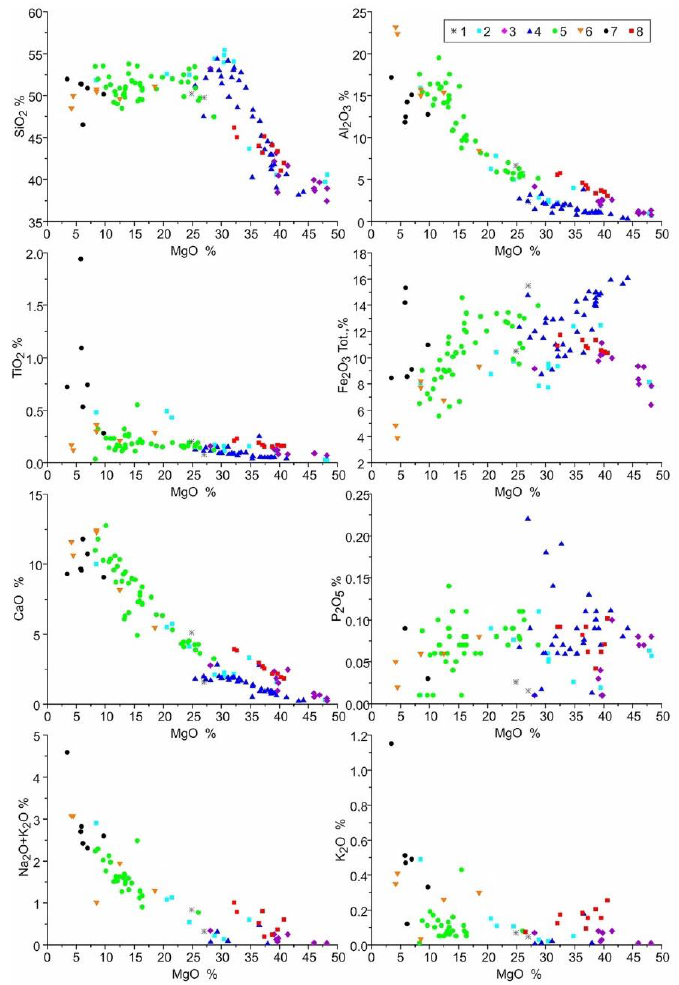
Figure 7. Petrochemical diagrams of MgO oxides in rocks of the Monchepluton and intrusive body (M-1 borehole). 1: The Marginal Zone rocks (Mt. Nyud); 2: I megacycle rocks (NKT); 3: II megacycle rocks (the Dunite Block); 4: III megacycle rocks (Mt. Sopcha); 5: IV megacycle rocks (Mt. Nyud); 6: V megacycle rocks (Mt. Vurechuaivench); 7: Metagabbro of the “10th Anomaly”; 8: Plagioharzburgites of the intrusive body (M-1